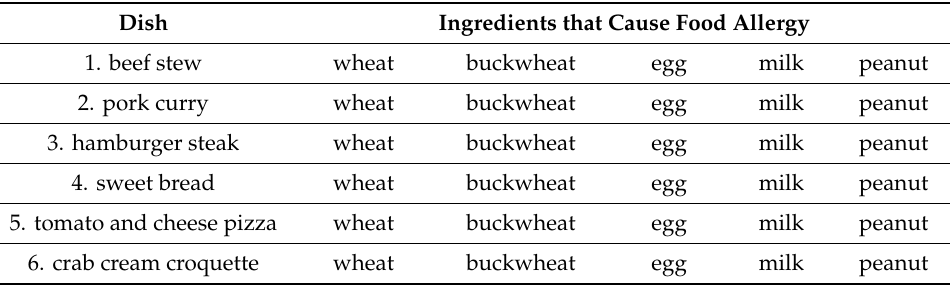
Table A2. Q2. Please circle allergic ingredients in each dish (please circle all that